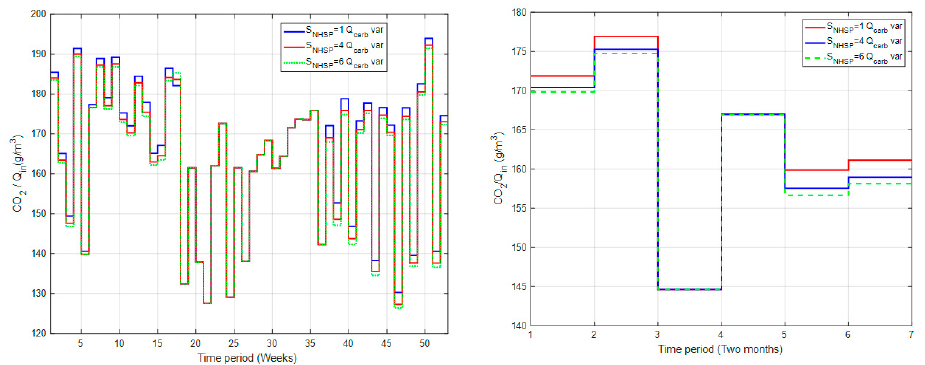
Figure A2. Weekly and bimonthly profile for total CO 2 emissions (g/m 3 ) indicators with alternative control actions.